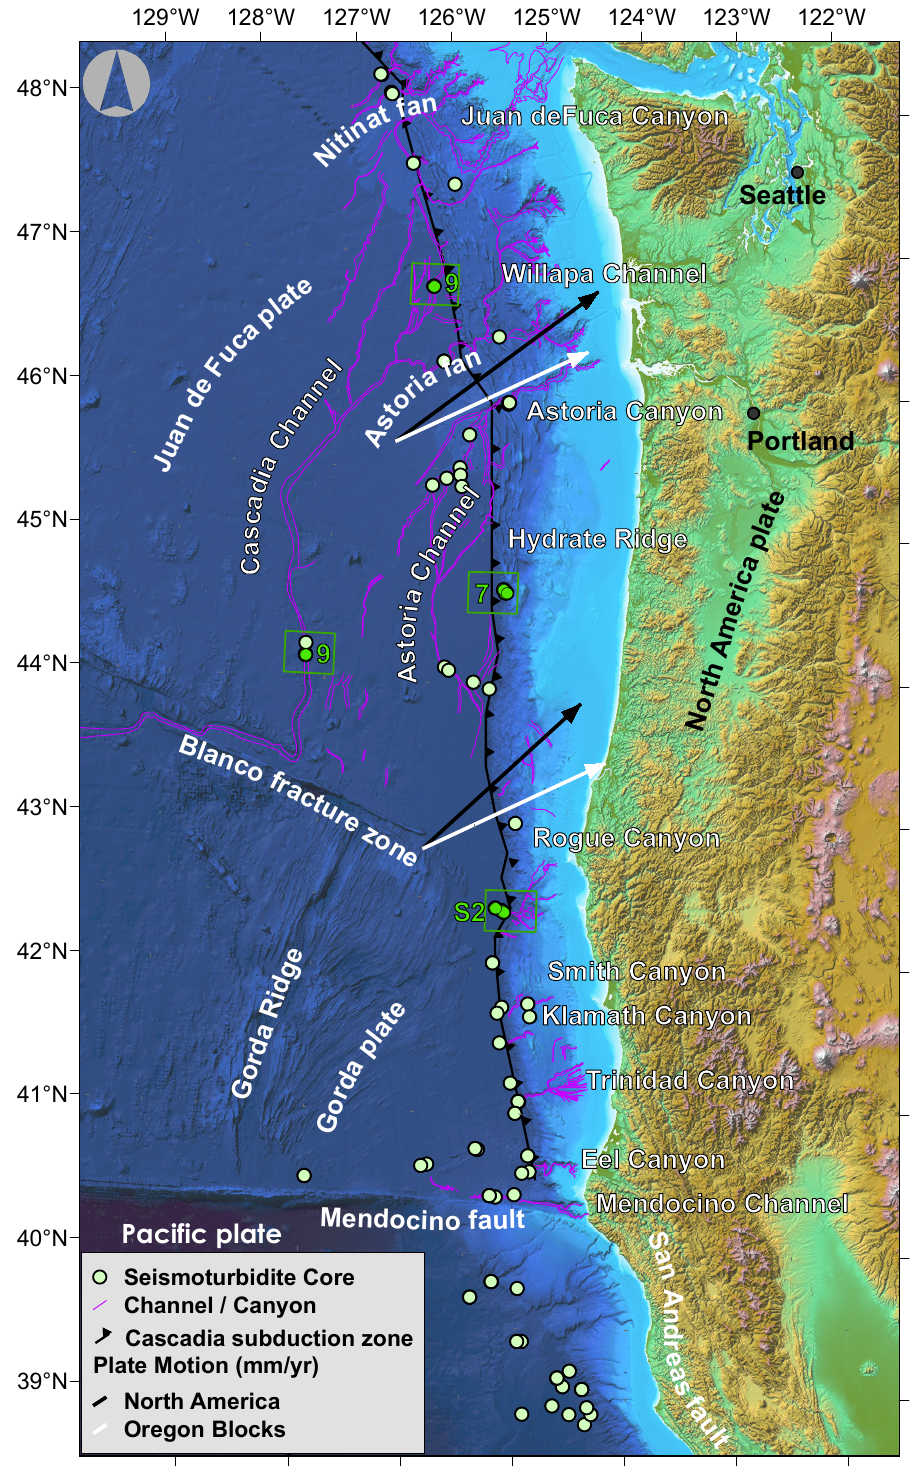
Fig. 3. Cascadia margin turbidite canyon, channel, and 1999, 2002, and 2009 core location map. Core sites are displayed as green circles and cores discussed in this paper are darker green. Bathymetric grid constructed from multibeam data collected in 1999, 2002, and 2009, Gorda plate swath bathymetry collected in 1997 (Dziak et al., 2001), and archive data available from NGDC. Bathymetry and topography in regions outside these higher resolution data sets are from the SRTM global data set (Smith and Sandwell, 1997). General location for Figs. 7, 9, and S2 are designated by green rectangles. Multibeam bathymetry data collected recently was compiled by Chris Romsos at Oregon State University (personal communication,